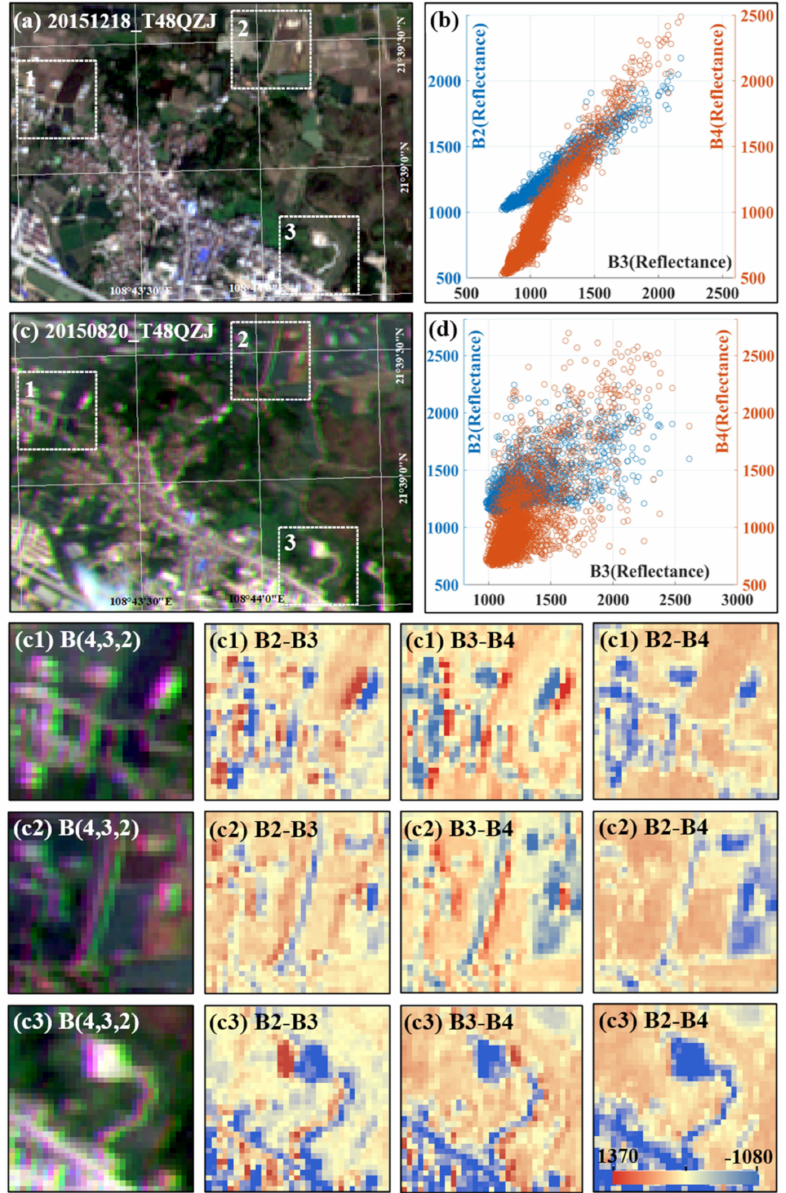
Figure 1. MSI images with and without discernible BBMR in the visible bands (Bands 2–4). ( a ) A subset of an MSI true-color image (48QZJ) acquired on 18 December 2015, without BBMR; ( c ) a subset of an MSI true-color image acquired on 20 August 2015, with BBMR in the same area as ( a ); and ( b – d ) the correlation between the reflectance of Bands 2–3 and Bands 4–3 inside three square image chips in ( a – c ). (Note that the reflectance values in ( b , d ) were scaled by 10,000.) ( c1 – c3 ) The true-color image and difference value between the visible bands of the three